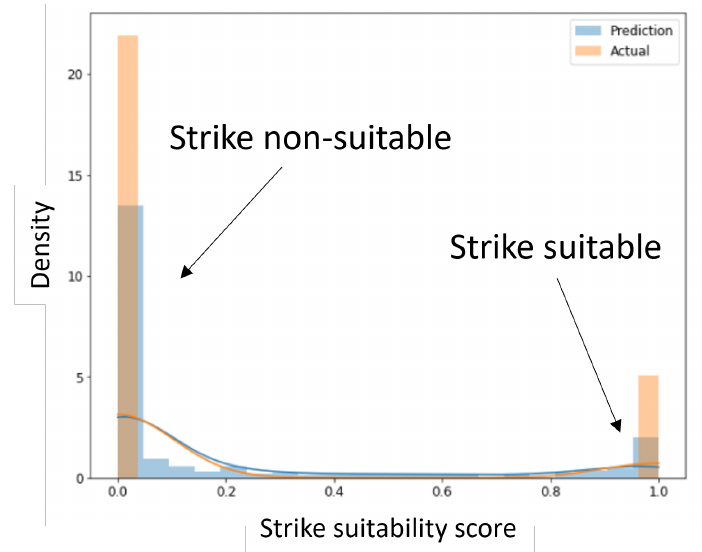
Figure 16. Pipeline probability